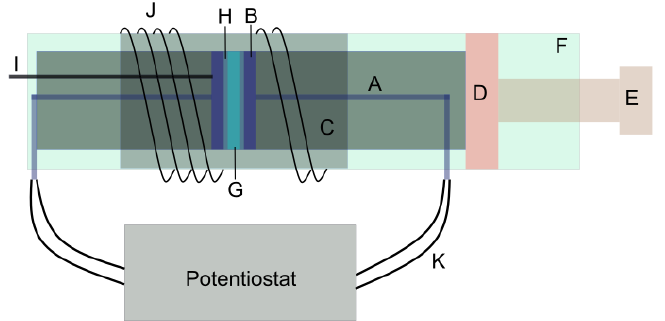
Figure 4. Experimental setup for direct membrane resistance measurement using two electrodes and electrochemical impedance spectroscopy. A. Platinum wire, B. Platinum disc electrode, C. Ceramic casing, D. Stopper, E. Tightening screw, F. Metal casing, G. IEM, H. Solution thin film, I. K-type thermocouple, J. Heating coil, K.